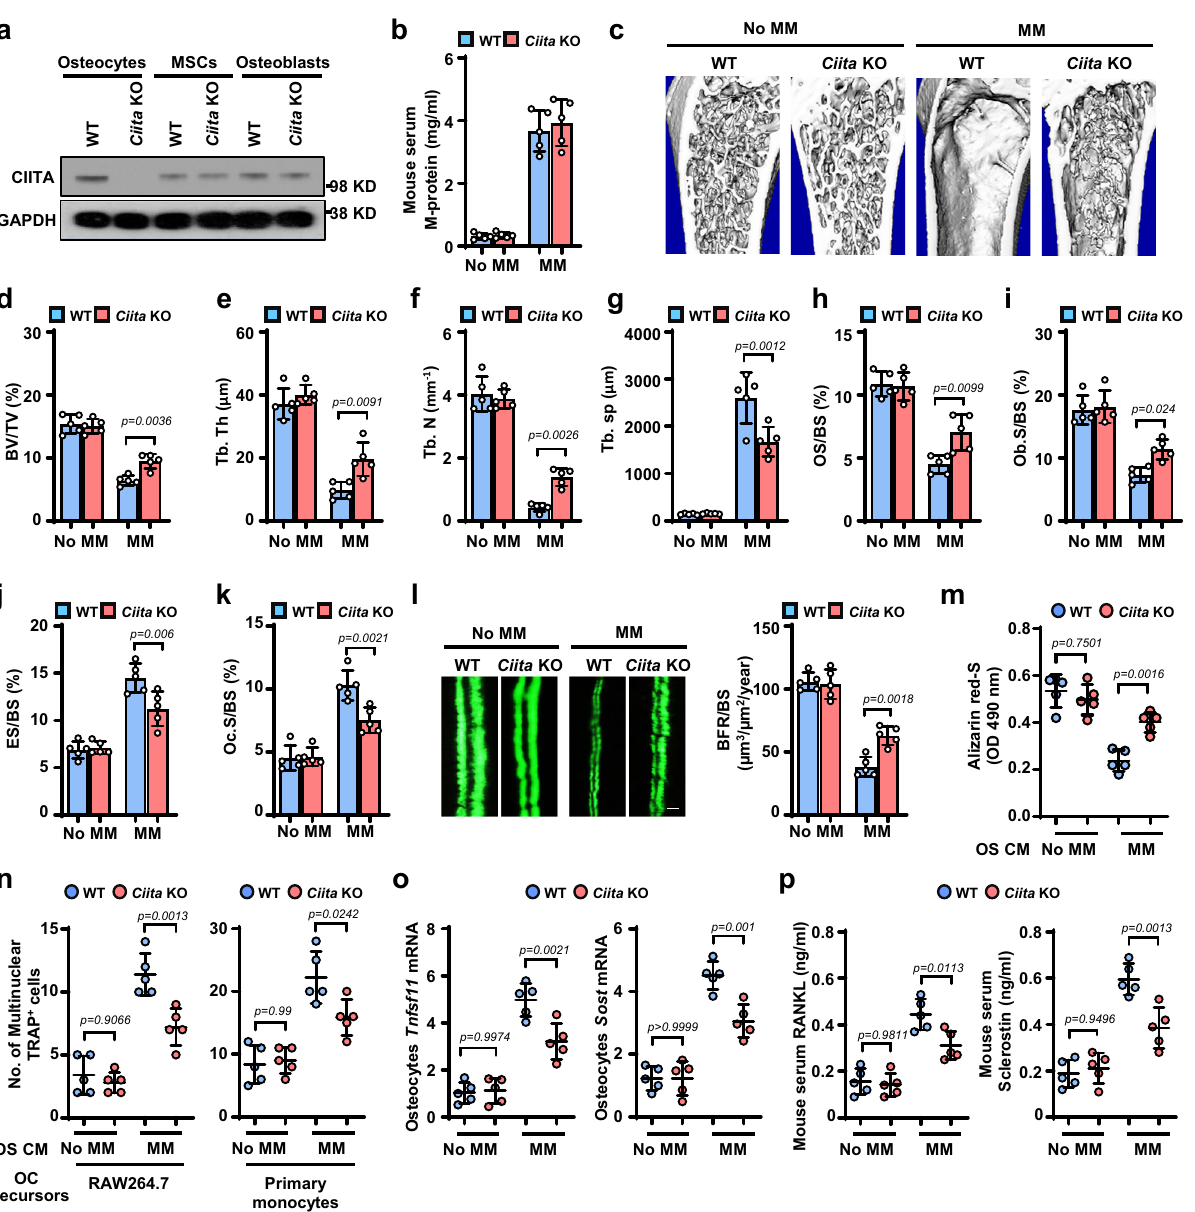
Fig. 2 De fi ciency of CIITA expression in osteocytes impairs myeloma-induced bone lesions. a Western blots show the expression of CIITA in osteocytes, MSCs, and osteoblasts isolated from wild-type (WT) or osteocyte-speci fi c Ciita -knockout ( Ciita KO) mice. The expression of GAPDH served as protein loading controls.Images shown are representative oftwo independent experiments. b – k WTand osteocyte-speci fi c Ciita KOmice were intrafemorally injected withthe murine myeloma cell line Vk12598 (1 × 10 6 cells/mouse). The mice not receiving myeloma cells (No MM) served as controls. Shown are the concentrations of M-proteins in mouse sera ( b ), representative μ -CT images of mouse femurs ( c ), and percentages of BV/TV ( d ), Tb.Th ( e ), Tb.N ( f ), Tb.Sp ( g ), OS/BS ( h ), Ob.S/BS ( i ), ES/BS ( j ), and Oc.S/BS ( k ). l BFR/BS was measured by calcein injection, and the bone sections were imaged and analyzed. Shown